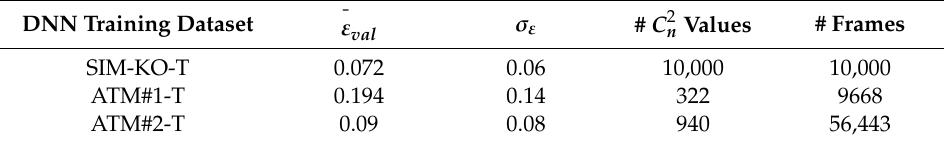
Table 2. Averaged prediction error ε val and its standard deviation σ ε for the Cnˆ2Net trained using di ff erent